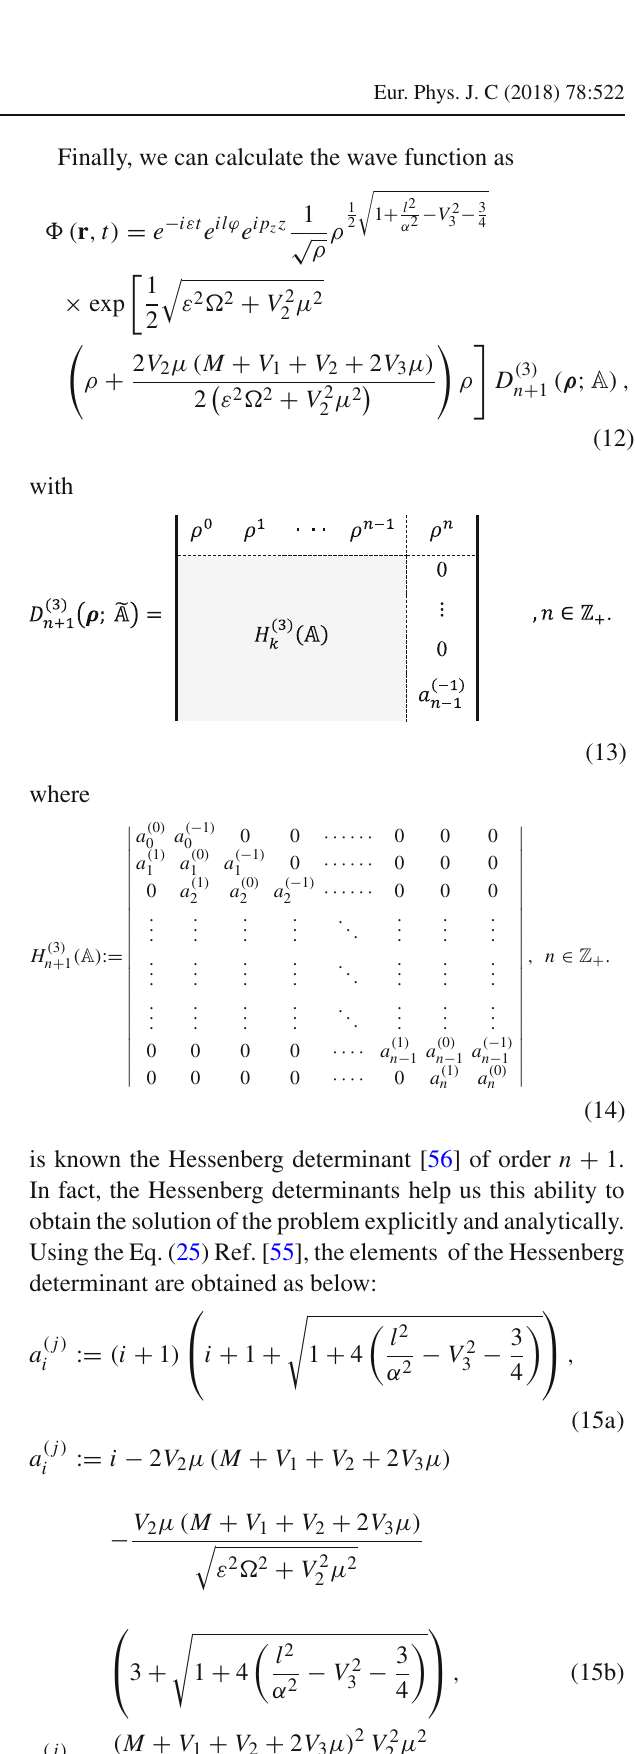
be transformed as ε 3 (cid:5) 3 (cid:6) ε 2 − 2 l ε(cid:5) − p 2 − ( M + 2 V α z interaction. ticity parameter (cid:5) and the parameter of α ,